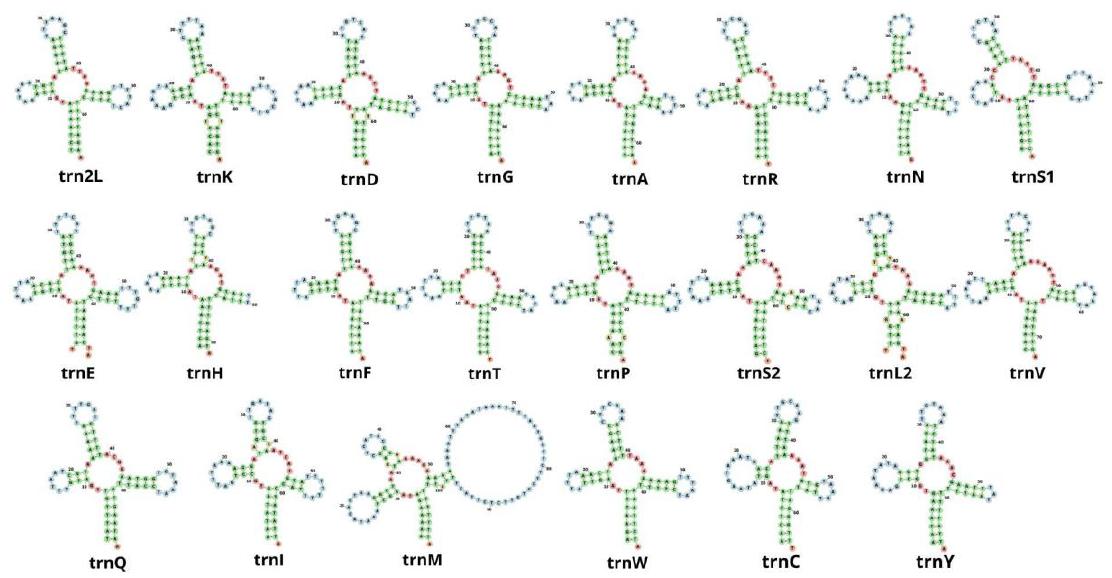
Figure 4. Secondary structures of 22 transfer RNA genes in Metopaulias depressus .